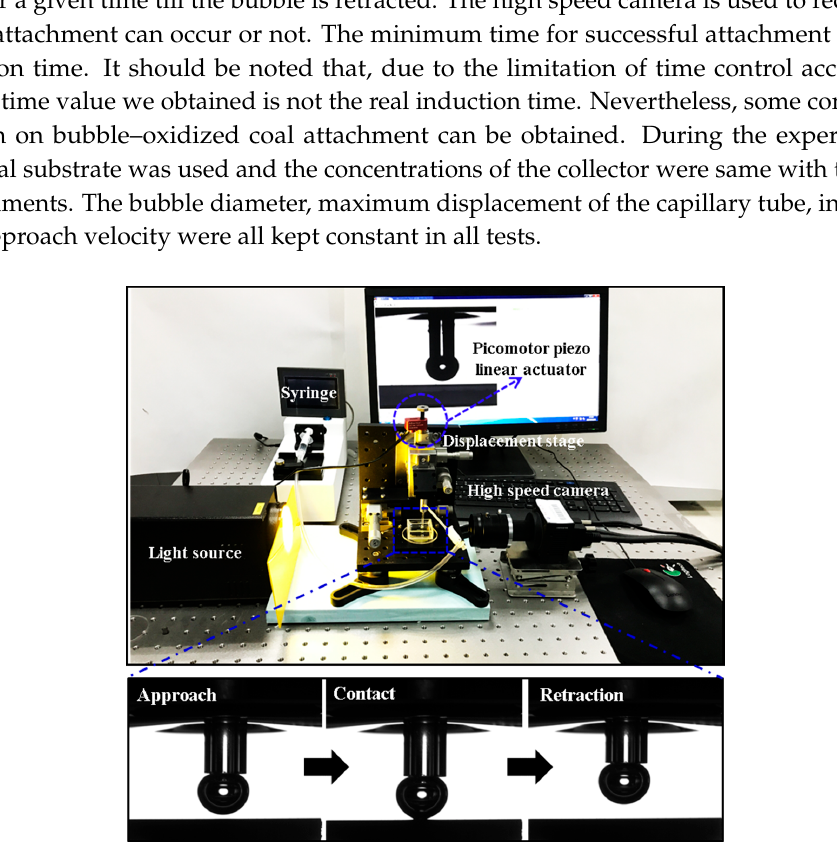
Figure 4. High speed visualization system for bubble–oxidized coal attachment.